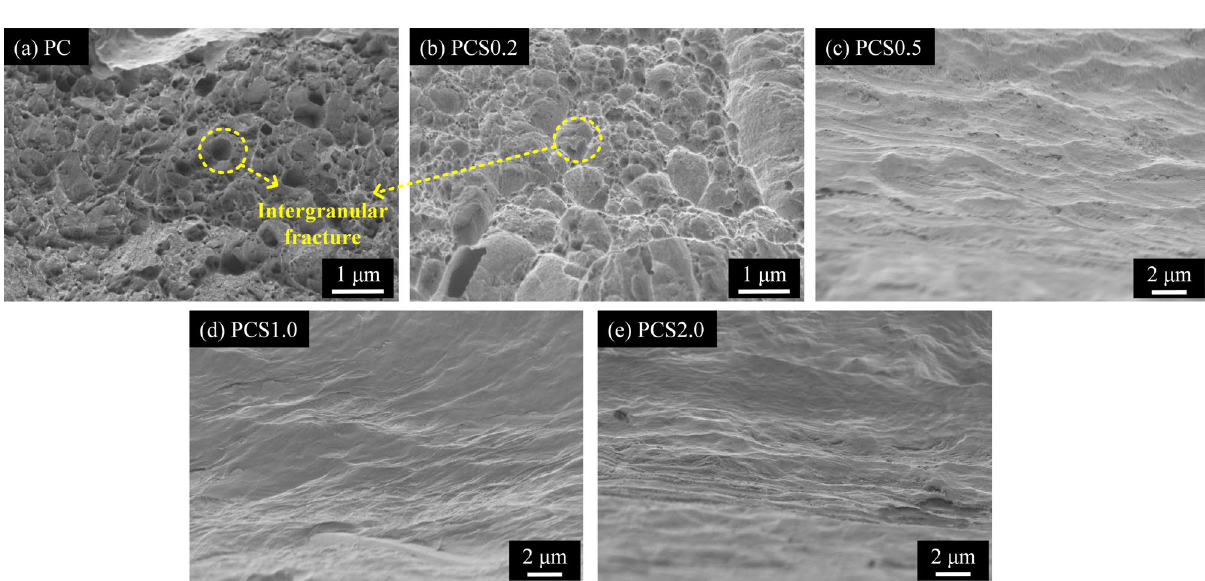
Figure 8. Fracture surfaces of Cu electroplated layers labelled as ( a ) PC, ( b ) PCS0.2, ( c ) PCS0.5, ( d ) PCS1.0, and ( e ) PCS2.0 after tensile